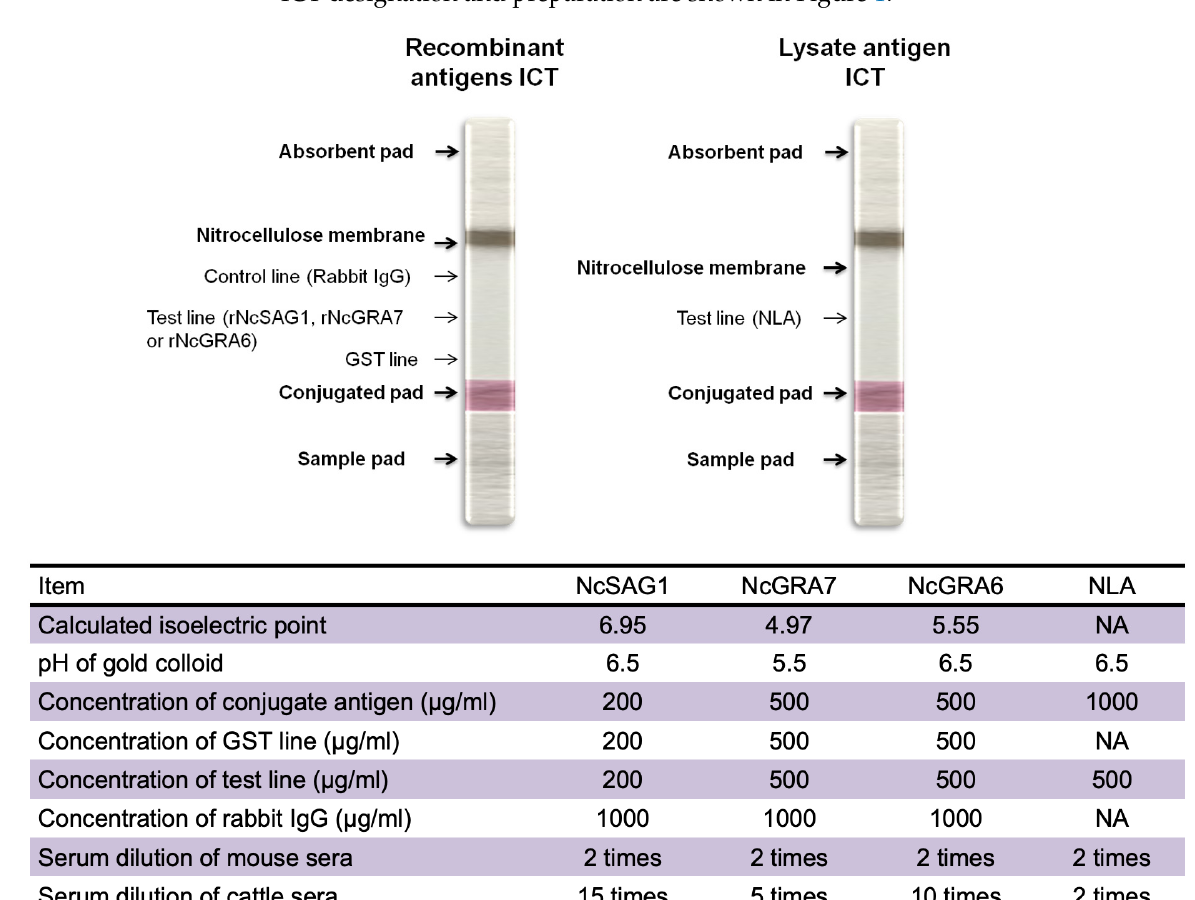
Figure 1. Immunochromatographic test (ICT) design and preparation. (Upper panel) Schematic diagram for the ICT prepared from recombinant antigens (NcSAG1, NcGRA7, or NcGRA6) or native lysate antigen from N. caninum tachyzoite (NLA). Three lines were sprayed onto the nitrocellulose membrane, including two control lines containing recombinant GST-tagged protein or anti-rabbit IgG and one test line containing recombinant antigen. While in the case of NLA-based ICT, only a line representing native antigen was prepared. (Lower panel) A table summarizing the used antigens concentrations and serum dilutions.